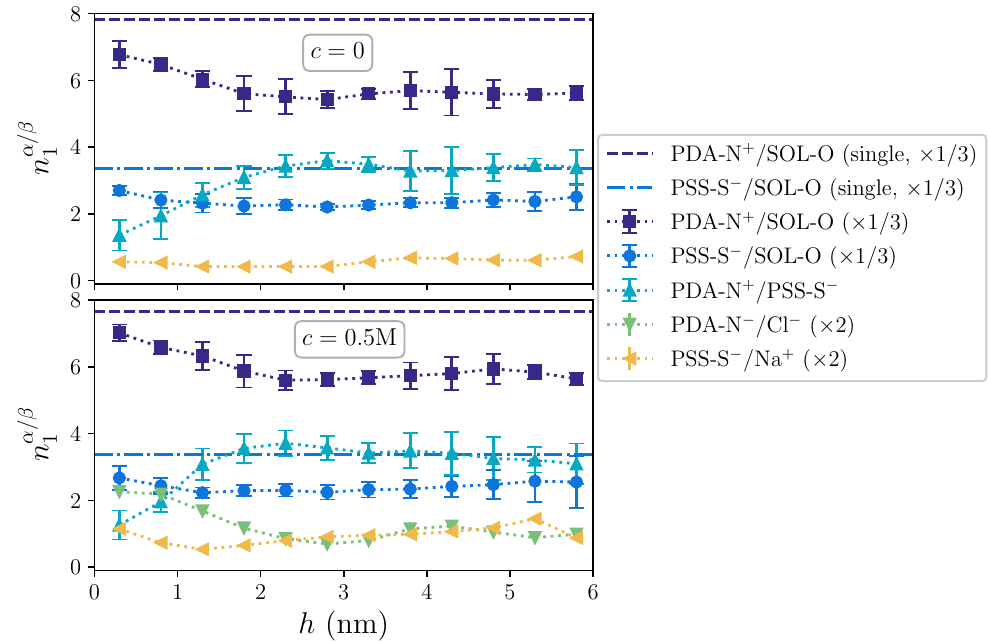
Figure 4. First coordination number of solvent and charges around OE charged groups as a function of the distance to the substrate, h , for c = 0 (upper panel) and c = 0.5 M (lower panel). Horizontal dashed and dashed-dotted lines indicate the hydration coordination for PDA-N + and PSS-S − , respectively, in single chain systems. Dotted lines are a guide to the eye. Curves for solvent and ions have been rescaled to ease the comparison. Error bars of the latter are not shown for the sake of